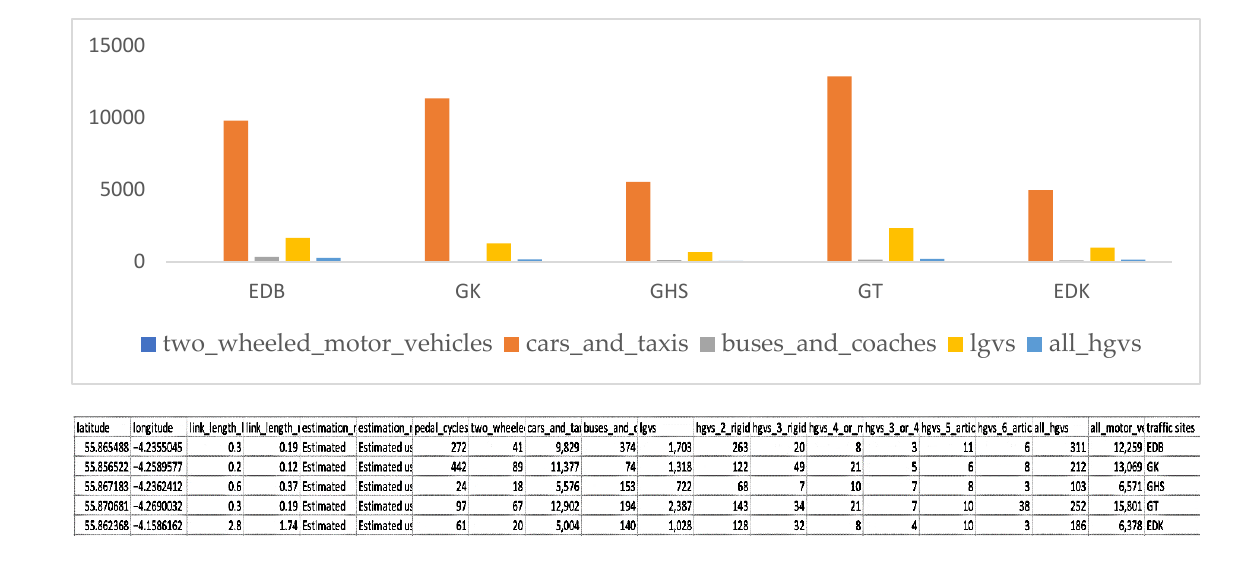
Figure 4. Annual daily traffic flow of the type of vehicles in various monitoring sites. Table 2. Spearman correlations between frequency components of road noise levels, air pollutants, and traffic flow